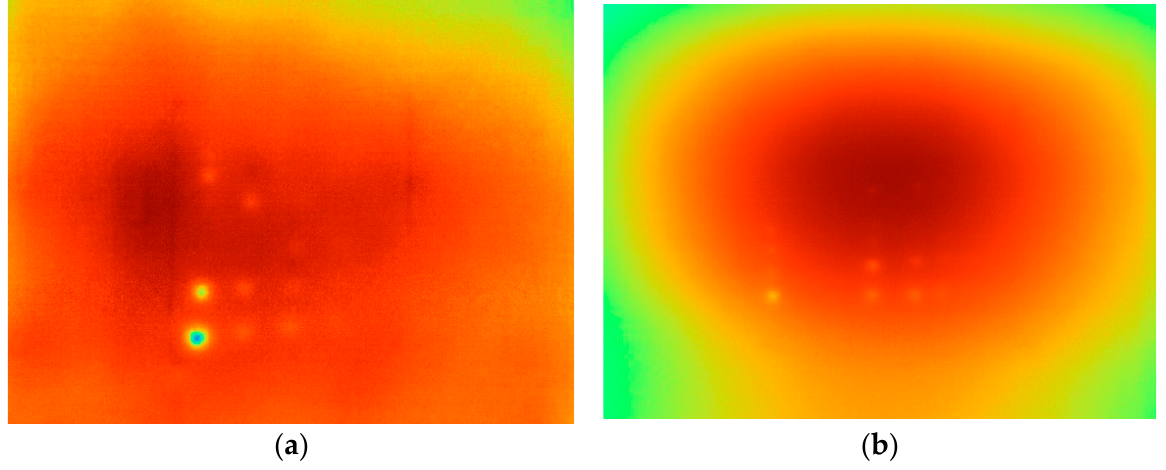
Figure 7. Two examples of the thermograms obtained from ( a ) cycle #6 of the heating–cooling combination of 40–80 performed on the east side, and ( b ) cycle #6 of the heating–cooling combination of 60–60 performed on the west side.